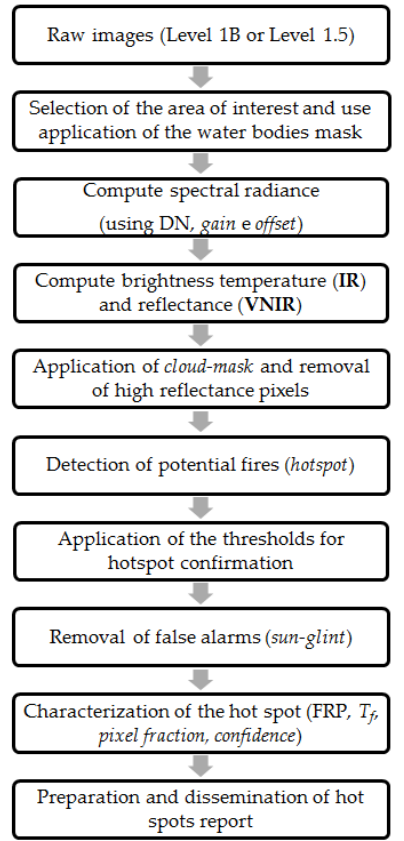
Figure 2. The common steps characterizing a fire-detection algorithm using remote sensing data (IR = InfraRed, VNIR = Visible & Near InfraRed, FRP = Fire Radiative